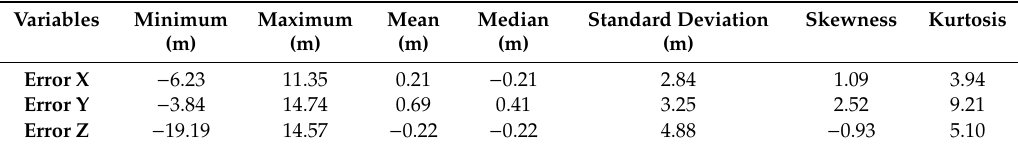
Table 2. Basic statistic of the 50 GCP dataset.